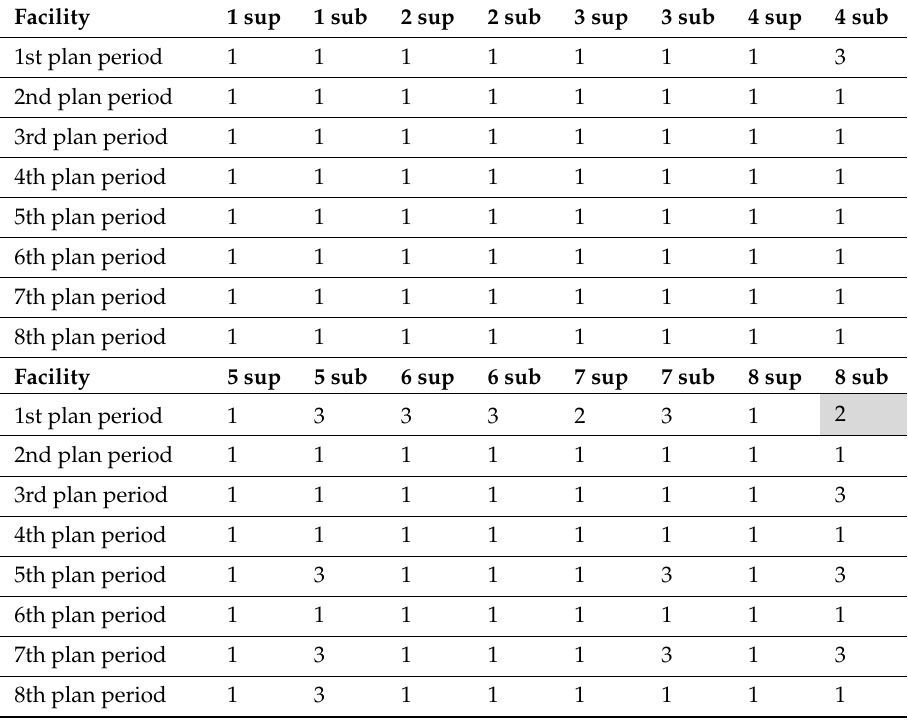
Table 13. Plan selection impact of budget ceiling (from USD 420 thousand to USD 419.67 thousand). Facility